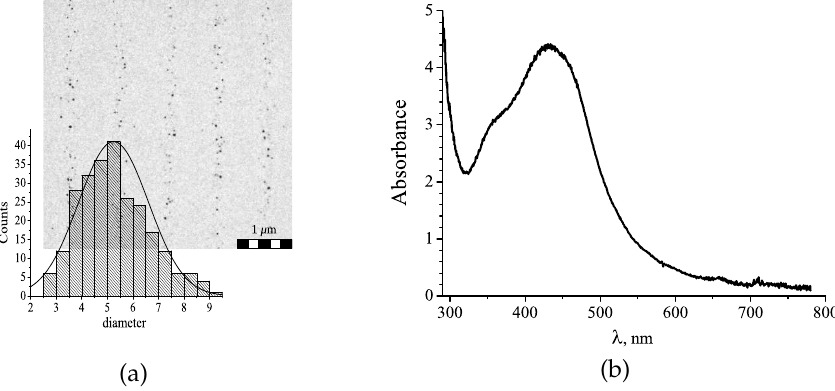
Figure 9. ( a ) TEM image of the grating with the in situ formed Ag NPs and histogram of the NP size distribution (the area is 3.5 µ m × 3.5 µ m; the average diameter is 5.25 nm; the standard deviation is 1.3 nm); ( b ) optical spectrum of the nanocomposite film containing Ag